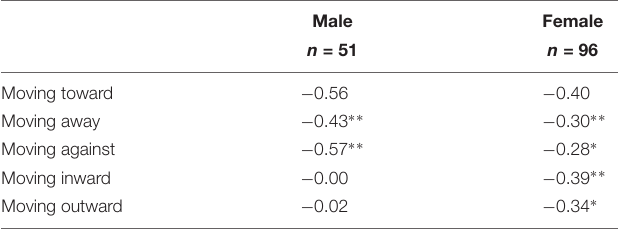
TABLE 6 | Correlation between the number of methods of harassment and the coping strategies used by male and female HCP victims of stalking and domestic violence ( N =